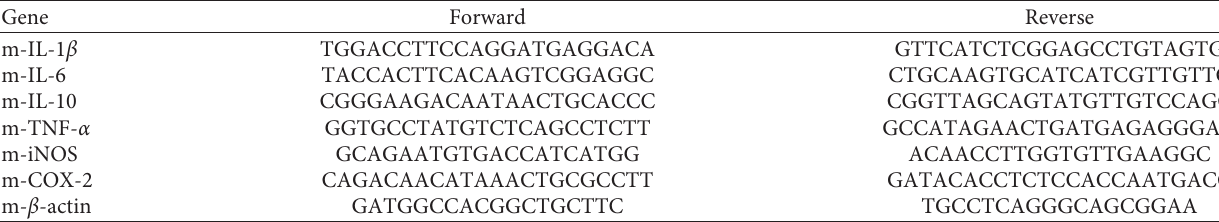
Table 1: A list of primers sequences for RT-PCR